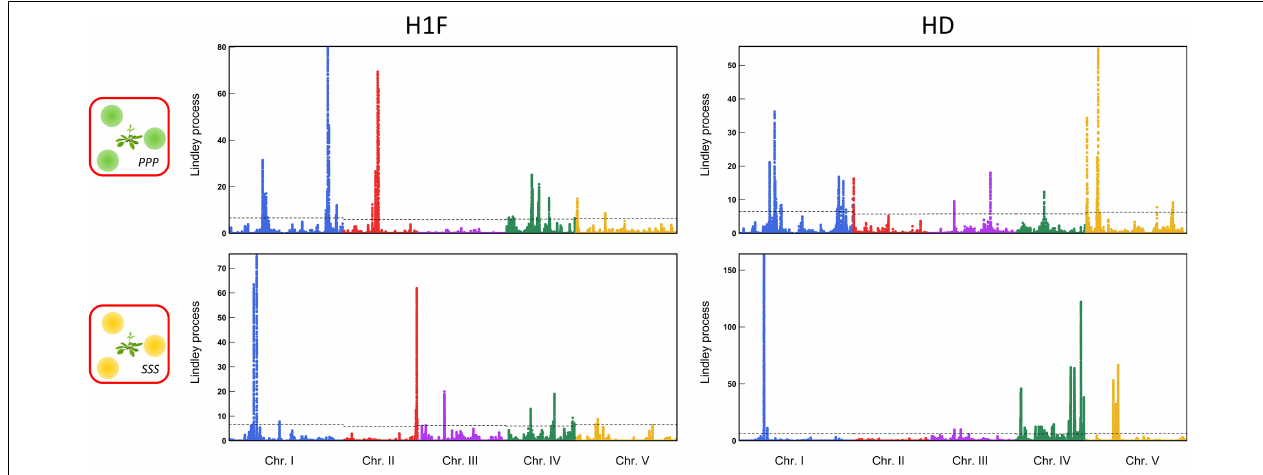
FIGURE 3 | Identification of genomic regions associated with bispecific interactions in the TOU-A population. Manhattan plots of genome-wide association (GWA) mapping results for the PPP and SSS treatments for the “height from the soil to the first flower” (H1F, left-panel) and the ratio “height from the soil to the first flower/the rosette diameter” (HD, right-panel) traits. The x -axis indicates the physical position of the 630,234 single nucleotide polymorphisms (SNPs) along the five chromosomes. The y -axis indicates the Lindley process scores estimated from –log 10 p -values from the mixed model implemented in the software genome-wide efficient mixed model association (GEMMA) using SNPs with a minor allele relative frequency (MARF) >